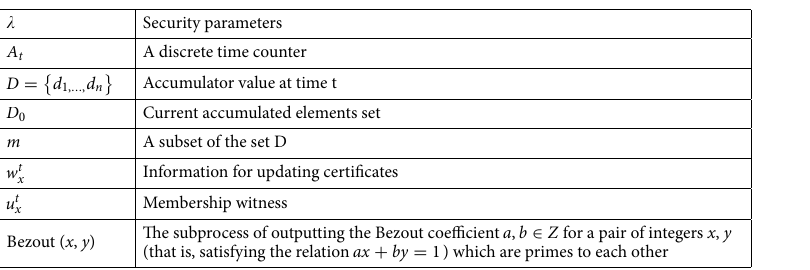
Table 1. Algorithm